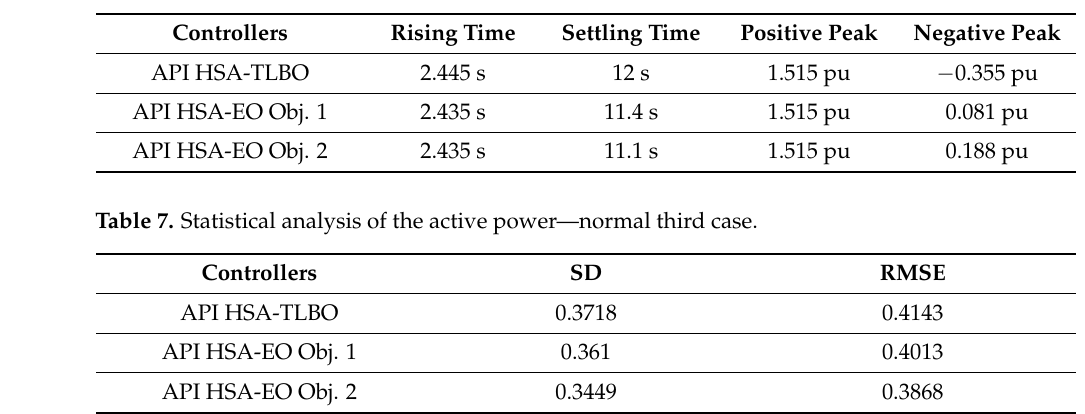
Figure 20. ( a ) Blade-angle responses of normal third case. ( b ) K p adaptive PI gain of normal third case. ( c ) K i adaptive PI gain of normal third case. Table 6. Numerical comparison between the controllers at normal third case.